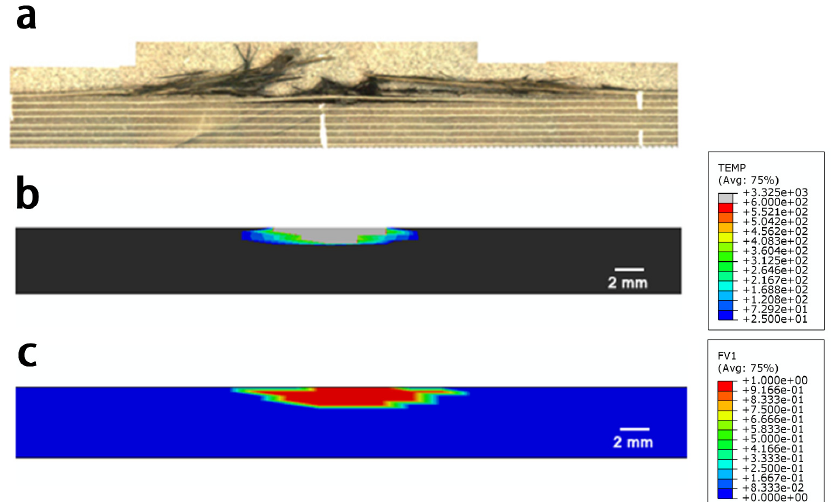
Figure 6. Comparison of the in-plane damage from experimental and simulated results: ( a ) ultra- sonic C-scan result; ( b ) surface damage result [25]; ( c ) simulated in-plane damage results from the isothermal pyrolysis diagram; and ( d ) non-isothermal pyrolysis method.